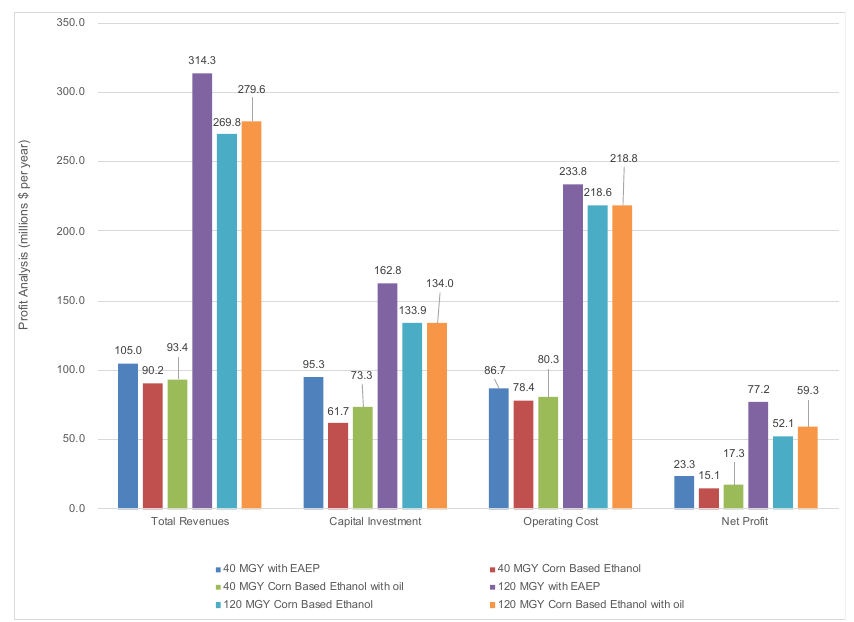
Fermentation 2021 , 7 , x FOR PEER REVIEW